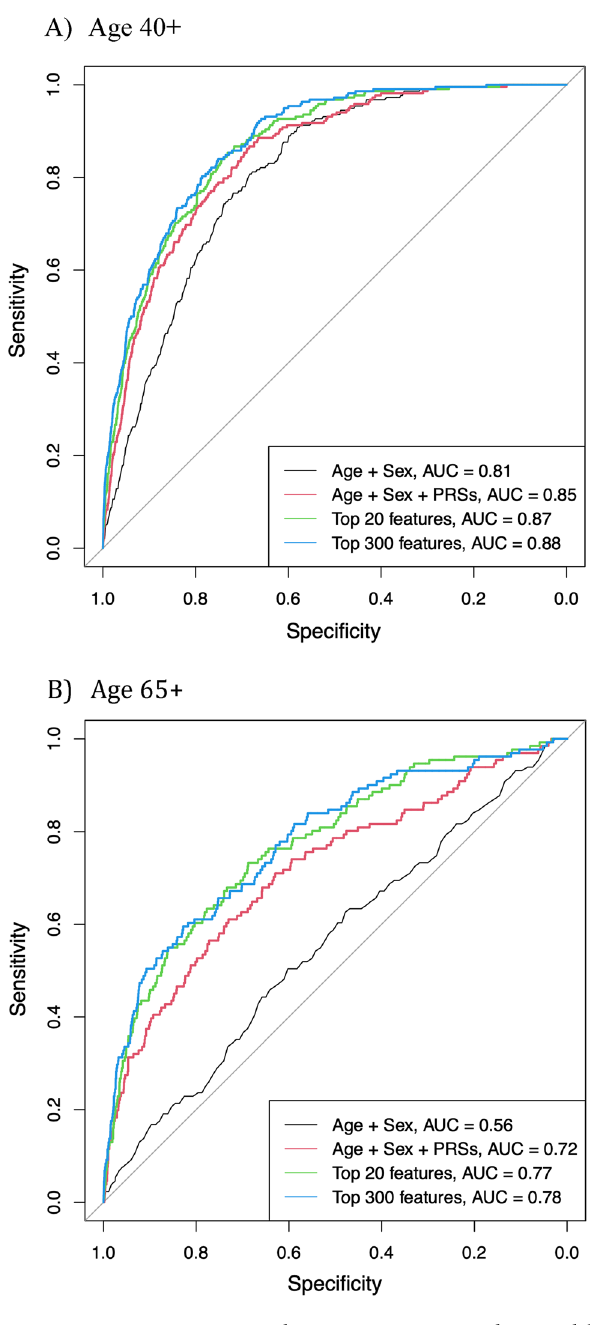
Figure 3. Receiver operating characteristic curves predicting Alzheimer’s disease. AUC curves for prediction accuracy of four models: (1) age and sex only, (2) age, sex, and PRSs, (3) the top 20 features, including PRSs, identified from XGBoost (features names shown in Fig. 3), (4) the top 300 features identified from XGBoost. ( A ) Age 40 + (age 40 and older) group; ( B ) Age 65 + (age 65 and older) group. A larger AUC representing better classification of Alzheimer’s disease status. AUC area under the receiver operating characteristic curve, PRS polygenic risk